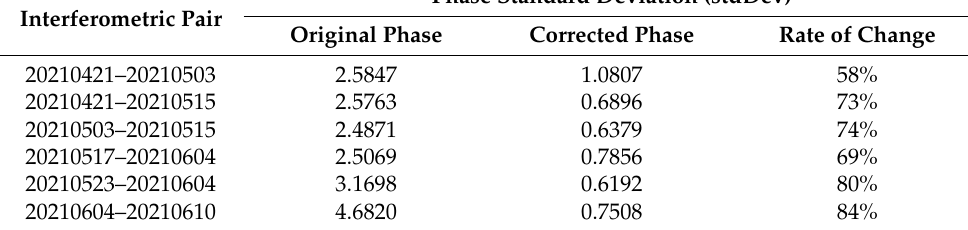
Table 2. The compared standard deviation of the unwrapping phase before and after correction of MLP neural network. Phase Standard Deviation (stdDev) Interferometric Pair Original Phase Corrected